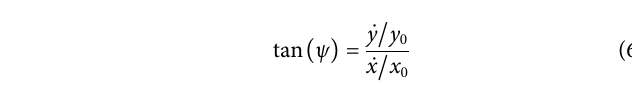
Frontiers in Astronomy and Space Sciences |